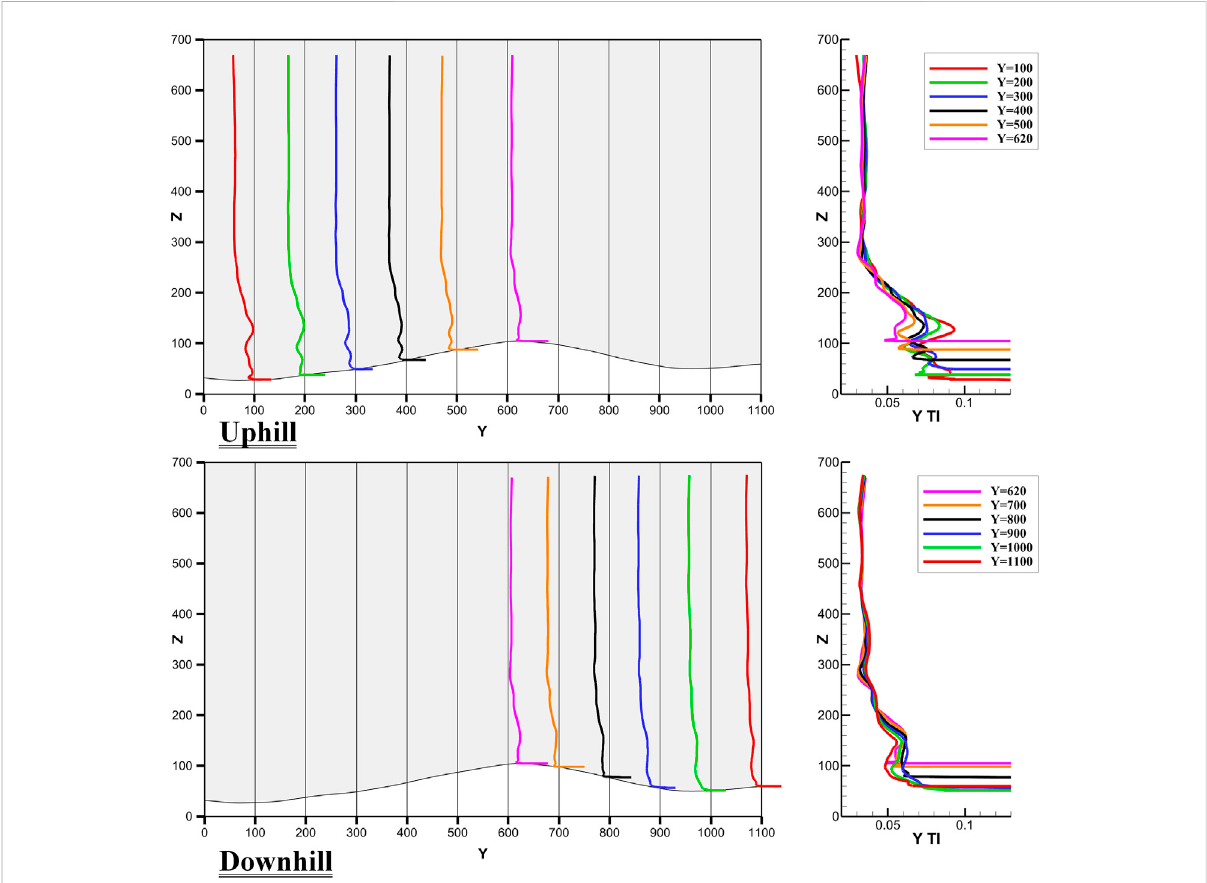
Simulated turbulence intensity pro fi les when X=320 m and Y=100 – 620 m (uphill) or Y=620 – 1100 m (downhill). For sub fi gures on the left, vertical axis (Z) represents height in meters, and horizontal axis (Y) represents fl ow direction in meters. For sub fi gures on the right, vertical axis (Z) represents height in meters, and horizontal axis represents turbulence